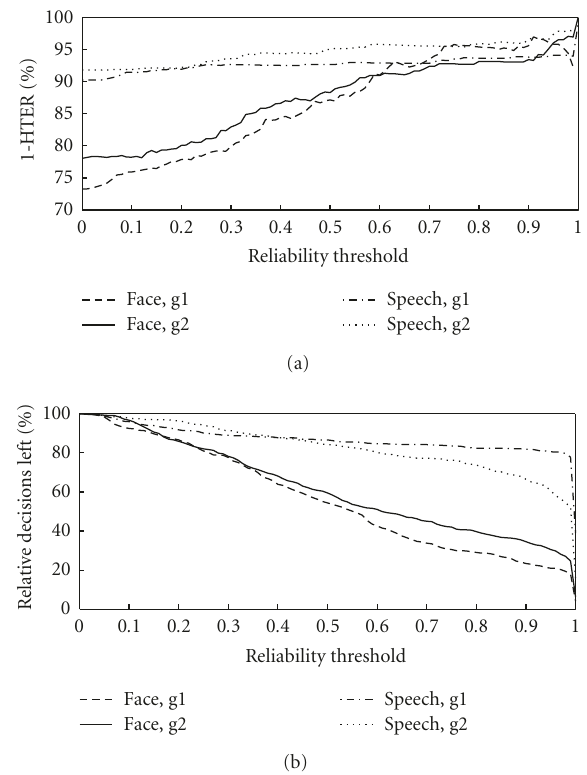
Figure 6: Distribution of reliability values on the g1 and g2 datasets for speech and face.